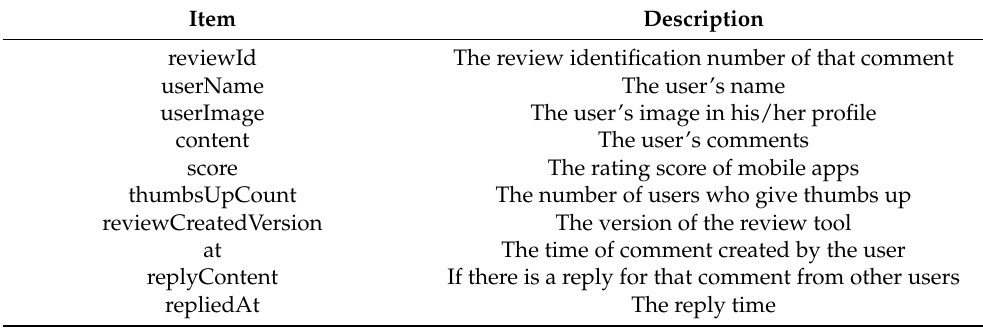
Table 2. Mobile apps meta-data on Google.